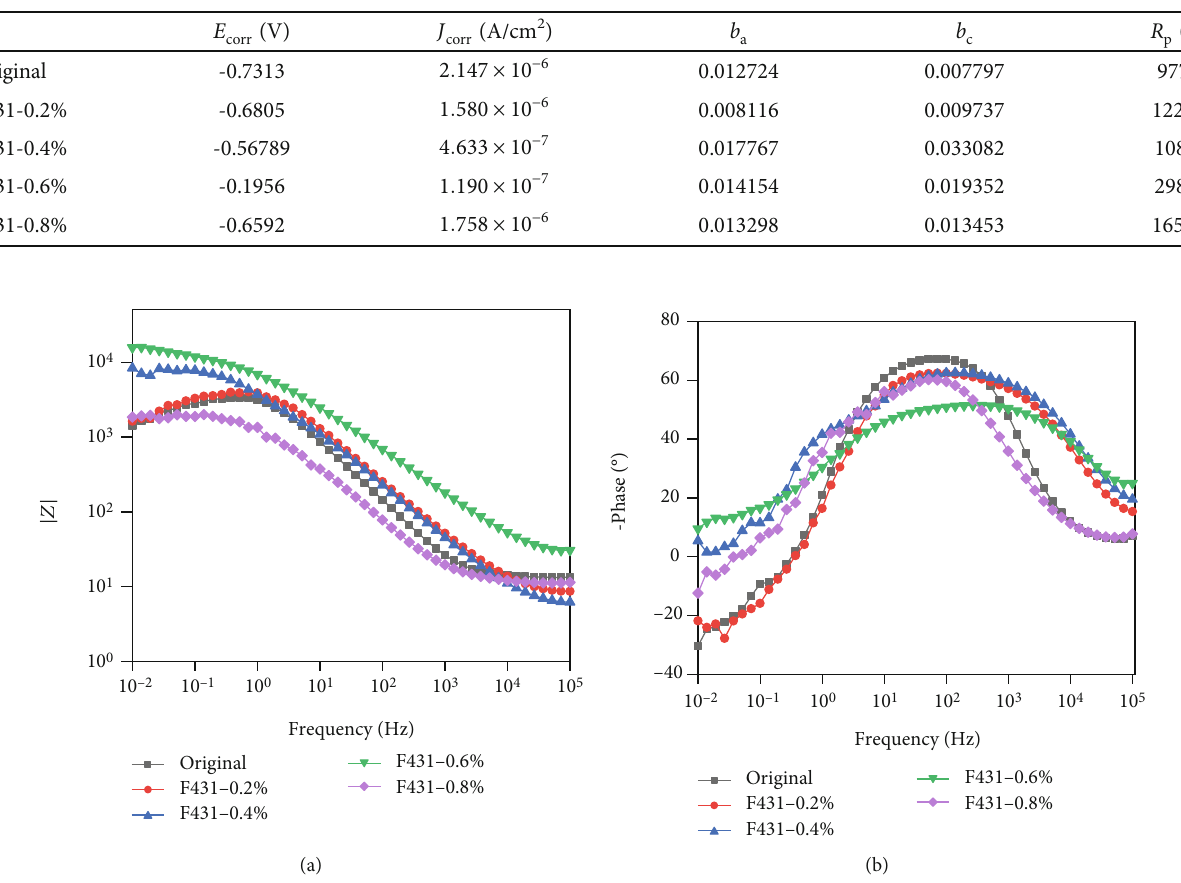
Figure 4: Bode of original and graphene additions of 0.2%, 0.4%, 0.6%, and 0.8% to anticorrosion